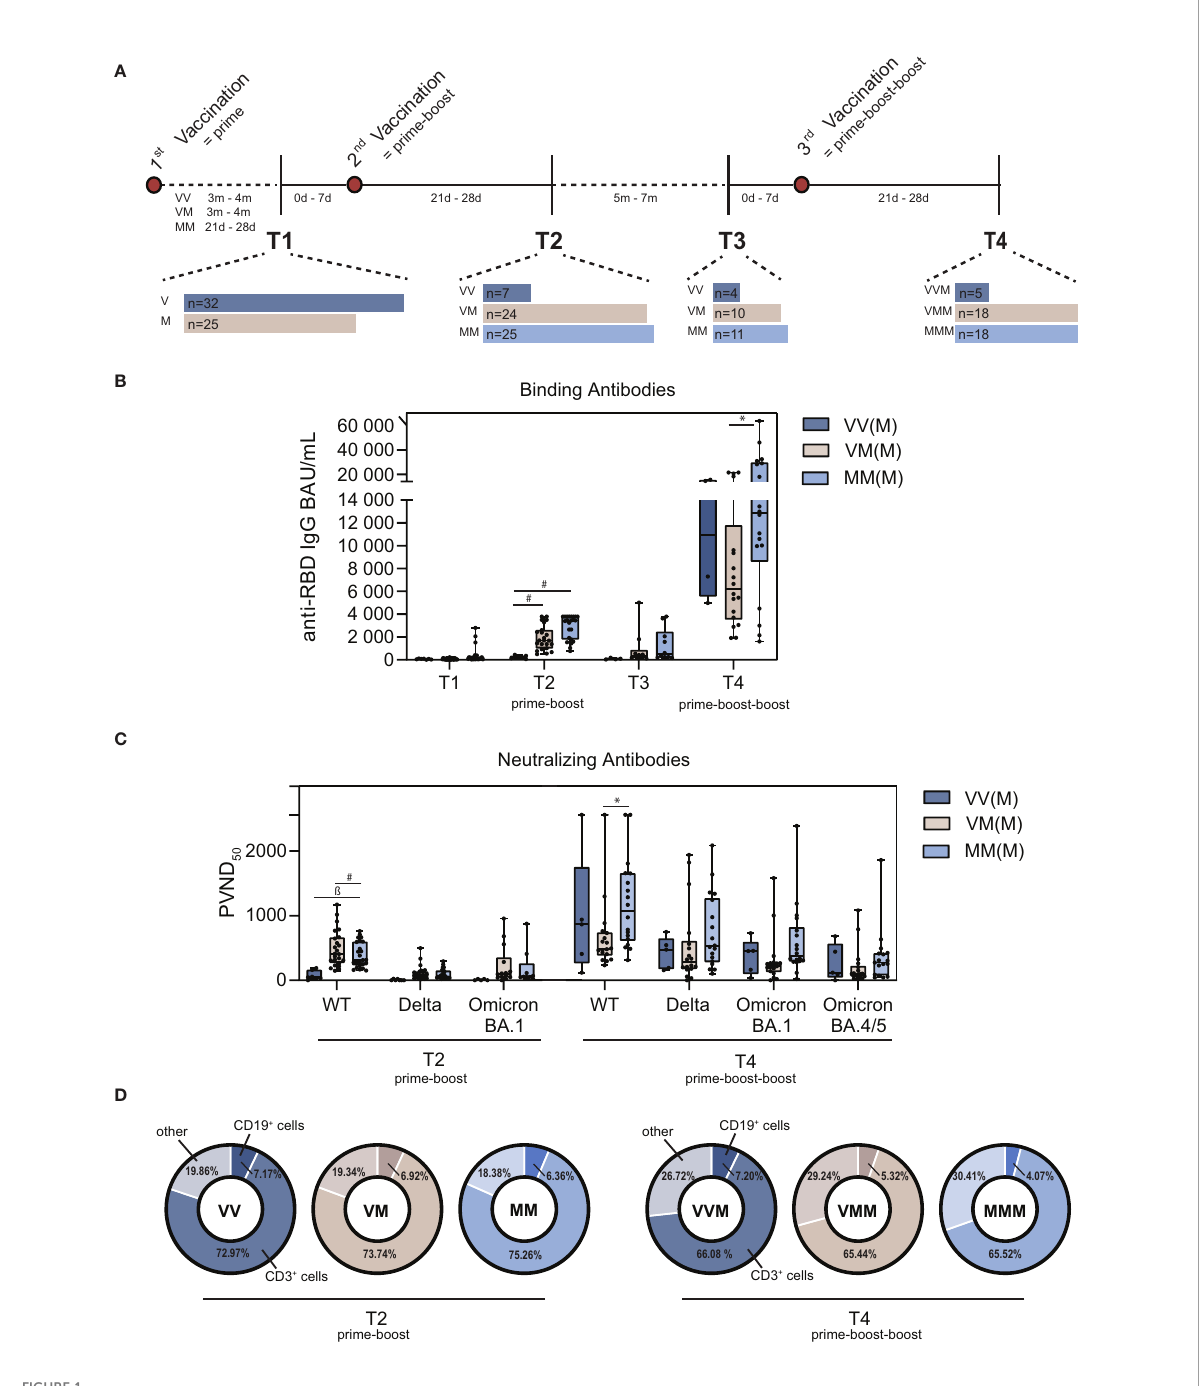
FIGURE 1 Characterization of the humoral immune signatures upon homologous vs. heterologous prime-boost-boost vaccine regimens. (A) Schematic illustration of the vaccination scheme, time periods between vaccinations and PBMC isolation (m=months, d=days). (B) Quanti fi cation of binding antibody units (BAU) of different vaccine regimens after prime-boost and prime-boost-boost. (C) Quanti fi cation of neutralizing antibodies as pseudotype virus neutralization dose 50 (PVND 50 ) against the wildtype (WT) Spike and variants of concern Delta, Omicron BA.1 and Omicron BA.4/5 after prime-boost and prime-boost-boost vaccination. (D) Proportion of CD19 + B cells and CD3 + T cells in total PBMC population, including NK cells, monocytes and dendritic cells, summarized as other cells. (M = mRNA-based vaccination, V = Vector-based vaccination). Statistical analysis was performed using Tukey ’ s multiple comparison test (* p=0.05; ǂ p=0.01; ß p=0.001, #